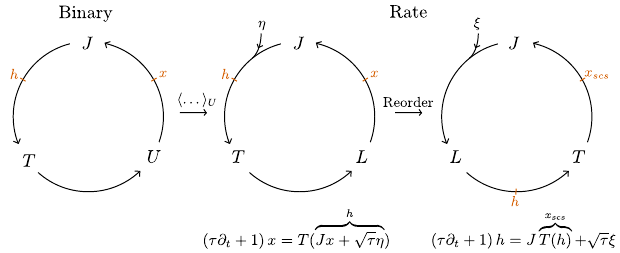
FIG. 14. Equivalence of binary (left) and rate models in the two different forms (A38) (middle) and (21) (right): mapping from output to input by identical matrix J ; asynchronous update process U with rate τ − 1 implies exponential convolution kernel leading to leaky integration [cf. Eq. (5)] identical to operator 1 Þ − 1 present explicitly in Eqs. (A38) and (21). L ¼ ð τ ∂ t þ Transitions between discrete binary states effect red noise η in input h (middle), which corresponds to white noise ξ that is low- pass filtered by L (right). Rate models differ in the order of application of this kernel and the connectivity, which yields equivalent dynamics because the two operators